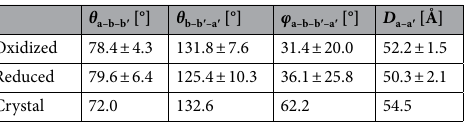
Table 2. The values from the structural analysis of the ER-60